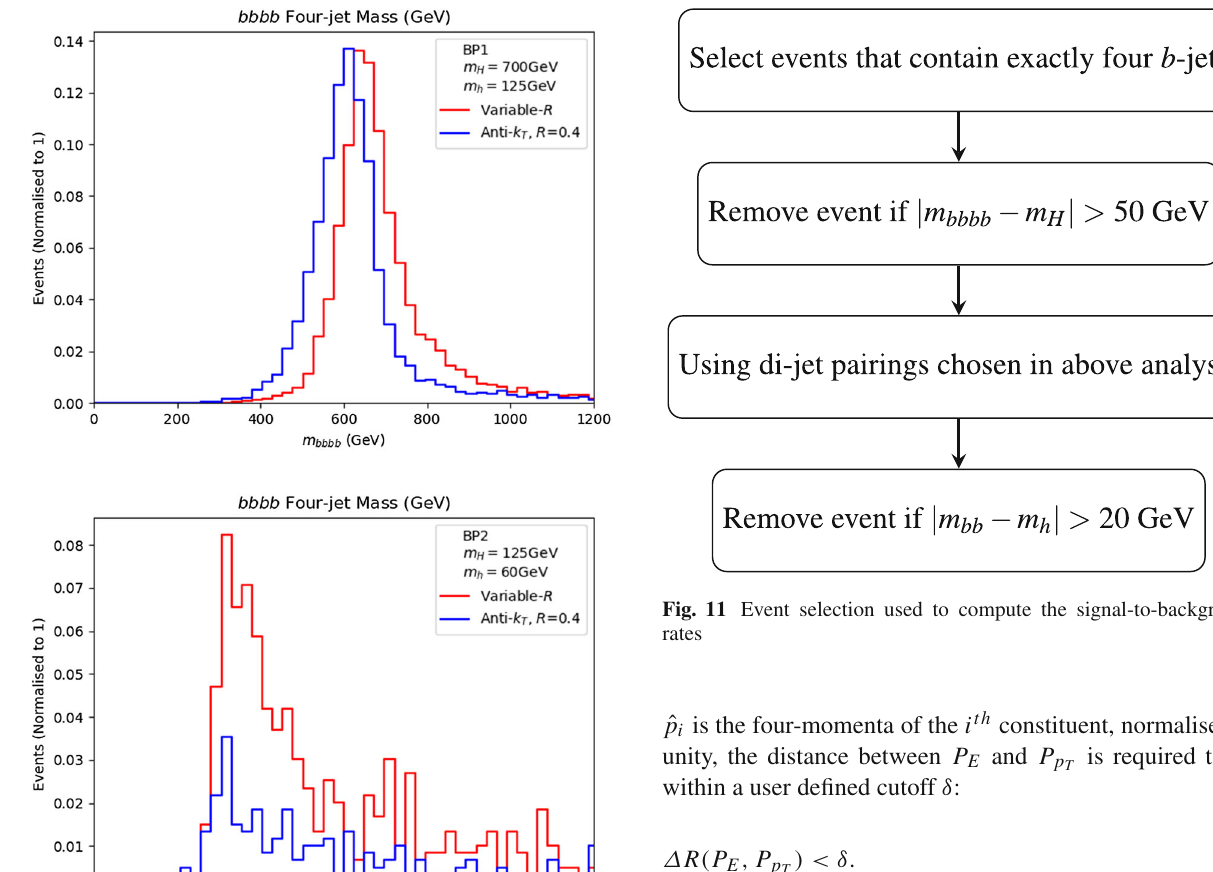
th constituent, normalised to is required to be T